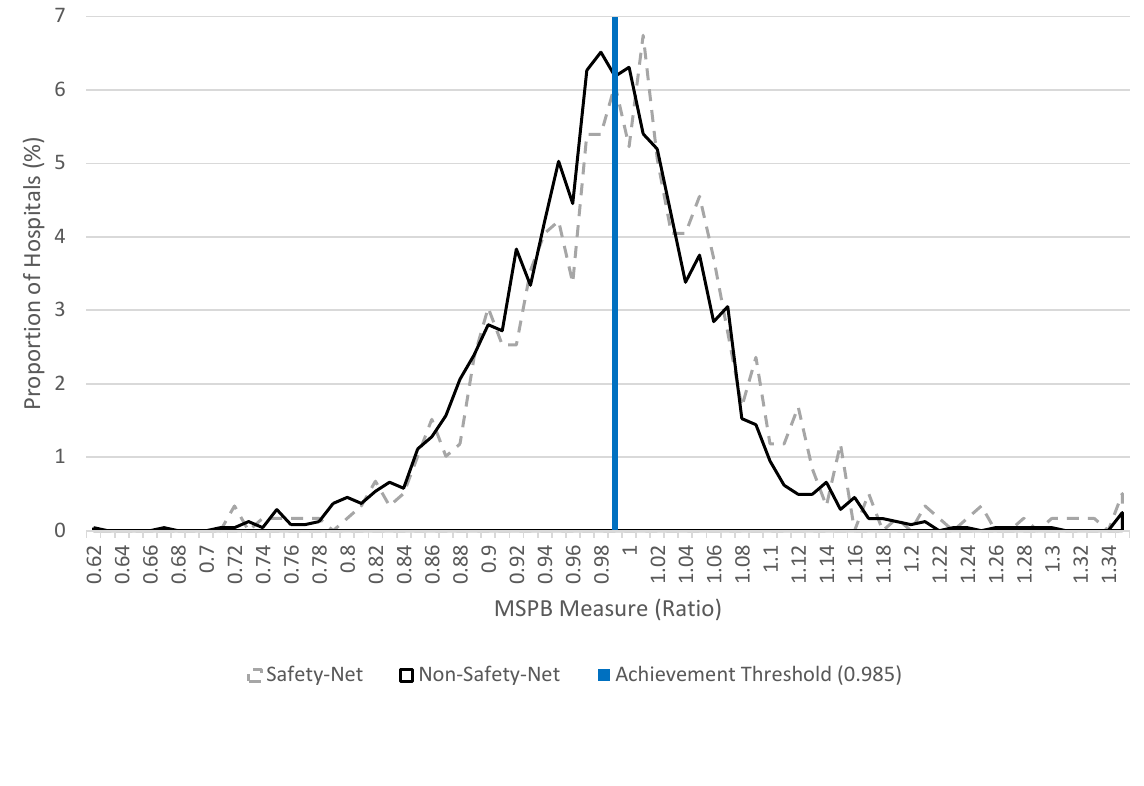
Figure 7.3. Distribution of MSPB measure performance by safety-net (high DSH) and other